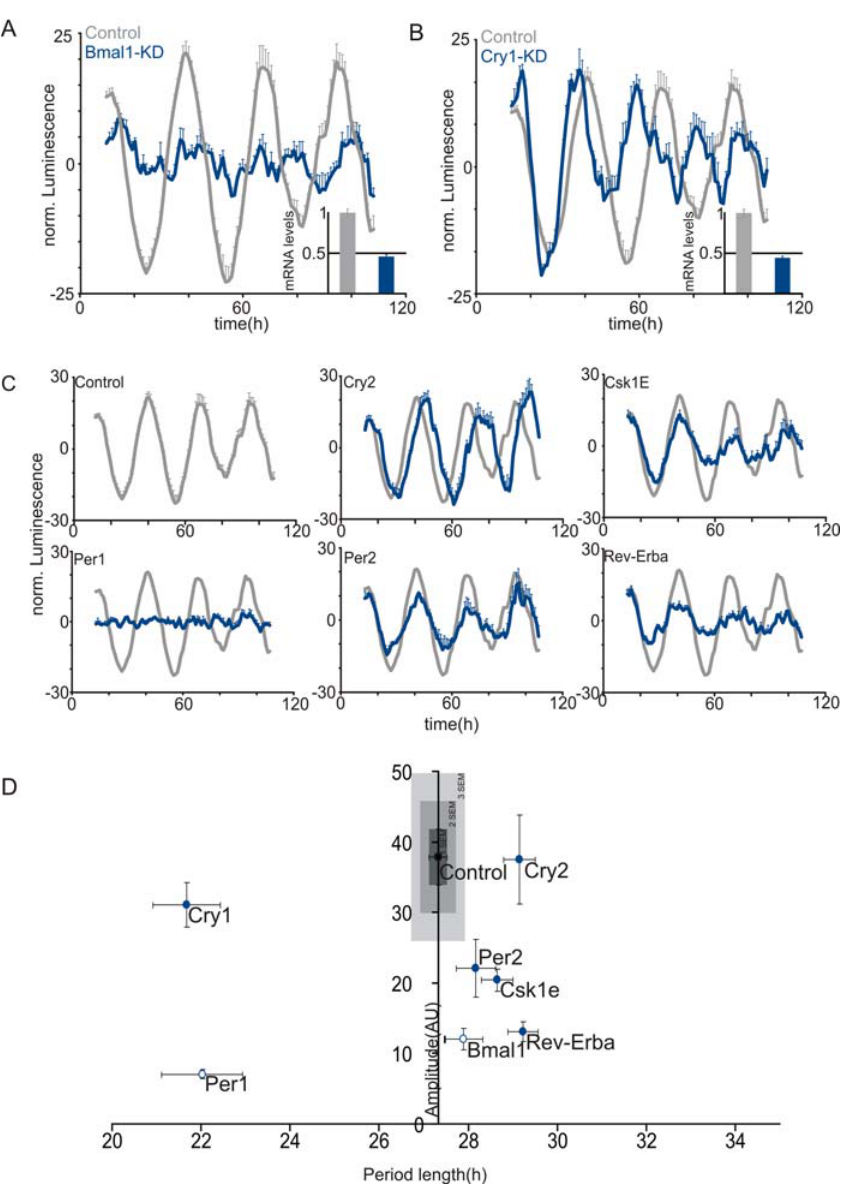
Figure 3. Assay validation. (A) Detrended luminescence traces of wells corresponding to either Bmal1 (left, n=4), Cry1 (right, n=4) or scrambled control siRNA (gray traces, both panels, n=16). Relative mRNA ( 6 s.d.) values were determined by Q-PCR (Inlets). (B) Detrended Luminescence traces of wells transfected with different siRNAs specific for the indicated circadian oscillator components (n=4) or scrambled unspecific siRNA control wells (n=16). (C) Amplitude and period length plots of the results obtained with siRNAs depicted in (a) and (b) (n=4, s.e.m). Multiples of s.e.m. of the control siRNA (n=16) are indicated in gray boxes. Arrhythmic wells are displayed as open circles.